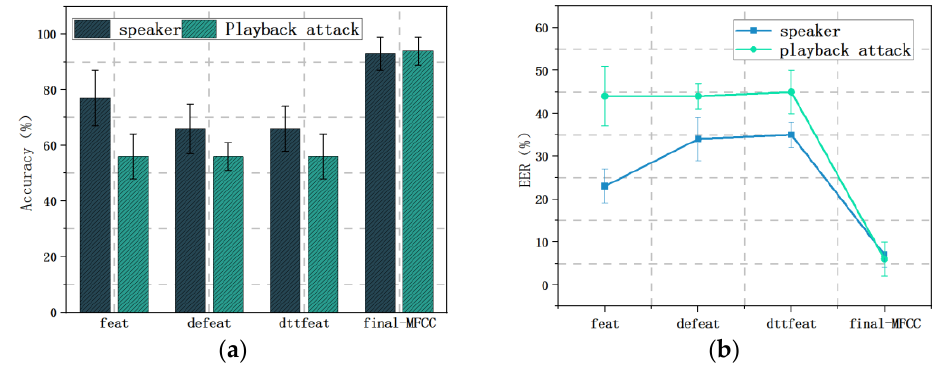
Figure 11. Different features: ( a ) Accuracy; ( b ) EER.